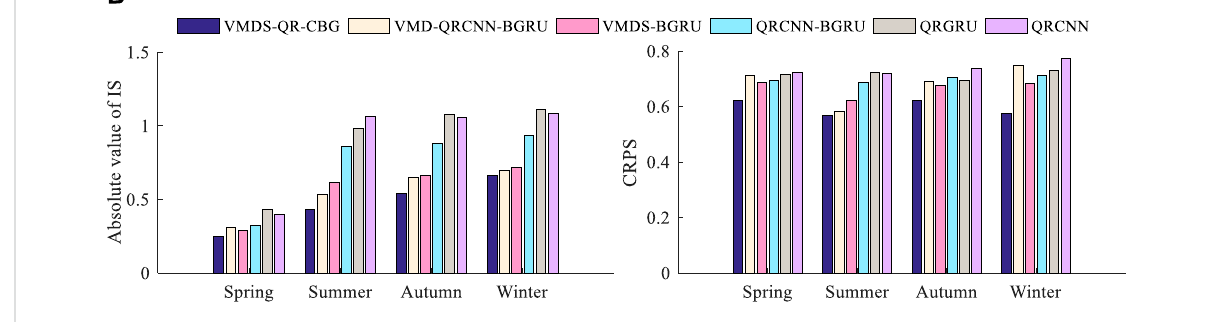
FIGURE 7 Comparison of prediction results indicators for different